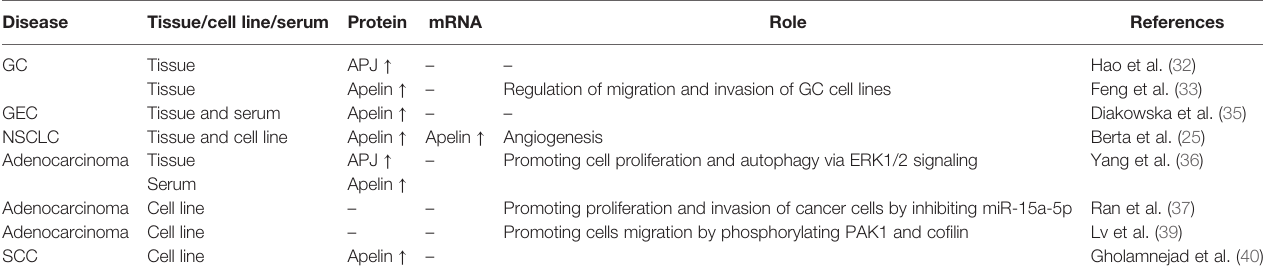
TABLE 1 | Expression and role of apelin/APJ signaling in gastric cancer, gastroesophageal cancer and lung cancer. Disease Tissue/cell line/serum Protein